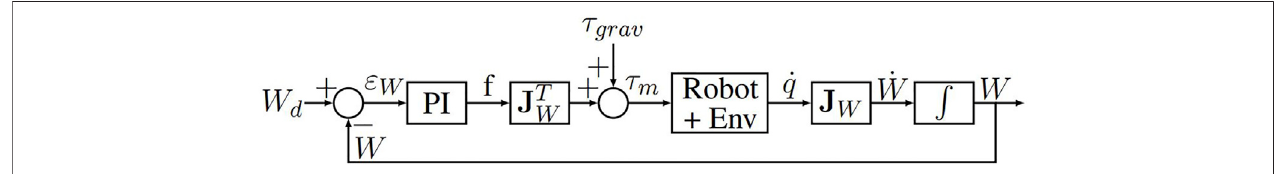
FIGURE 4 | Control law of the robot ’ s wrist W.